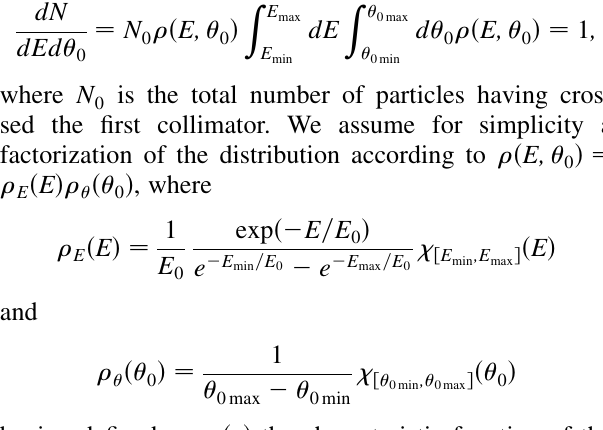
FIG. 13. Upper frame: Plot of the function g ð E Þ ¼ (cid:9) ð E Þ which gives the fraction of particles having overcome (cid:9) E the second collimator, at a given energy, whatever their initial value of angular deviation (cid:7) angular distribution whose lower bound is (cid:7) frame: The same as the upper frame with a larger value of the angular spectrum lower bound (cid:7) spectrum is